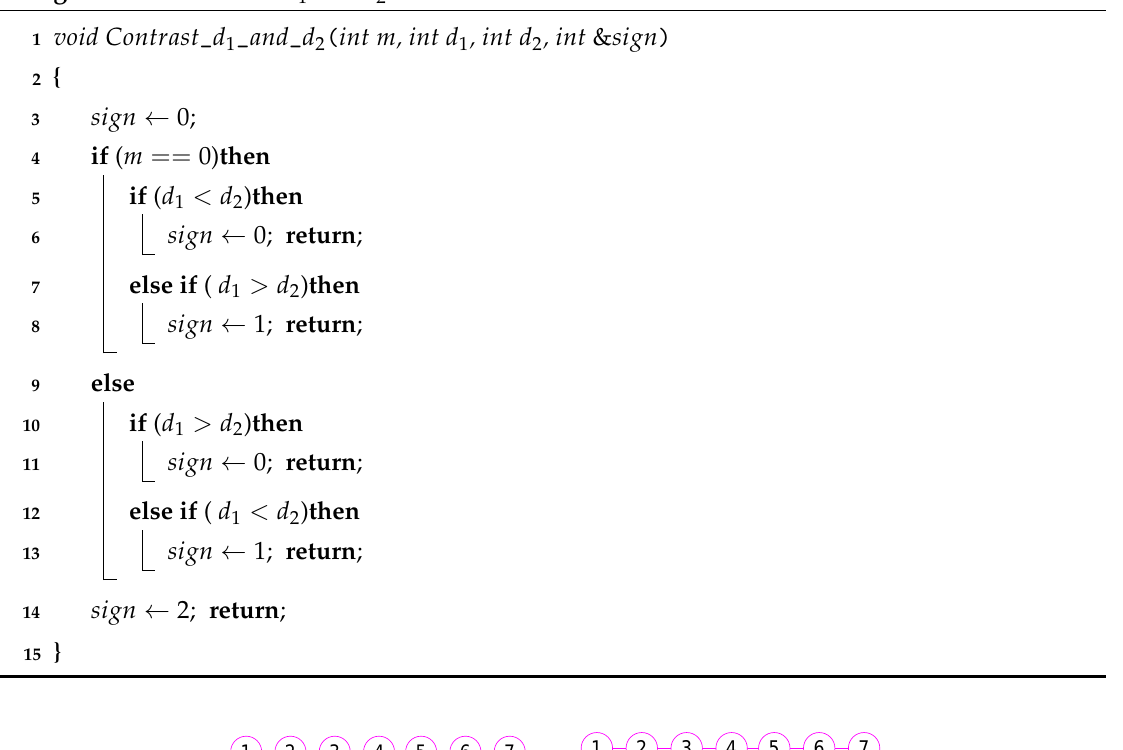
Algorithm 4: Contrast d 1 and d 2 .